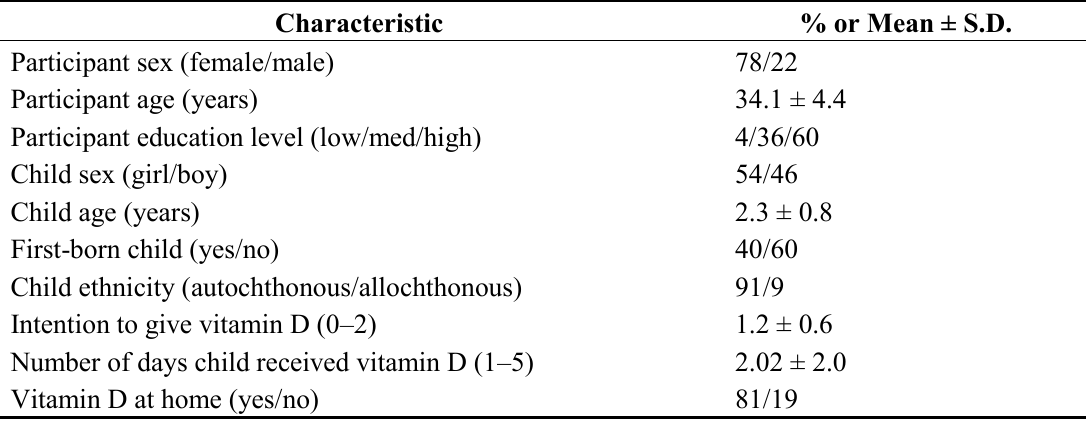
Table 1. Baseline characteristics of participants ( n =